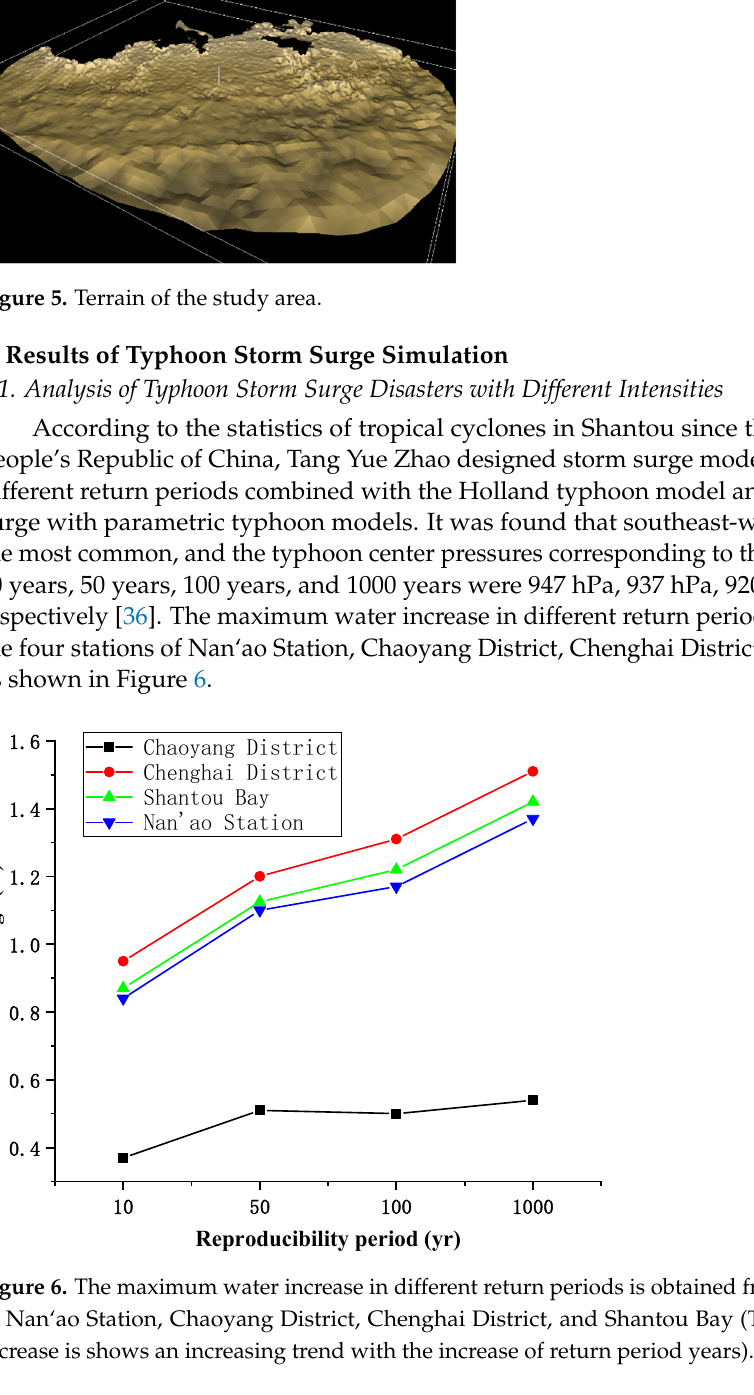
Figure 4. Bathymetric chart (The figure shows the water level in Shantou offshore. The colder color means a deeper water level).